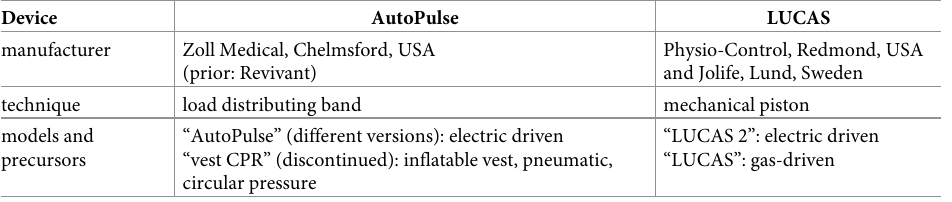
Table 1. Mechanical CPR devices applied by German Resuscitation Registry participants during our study